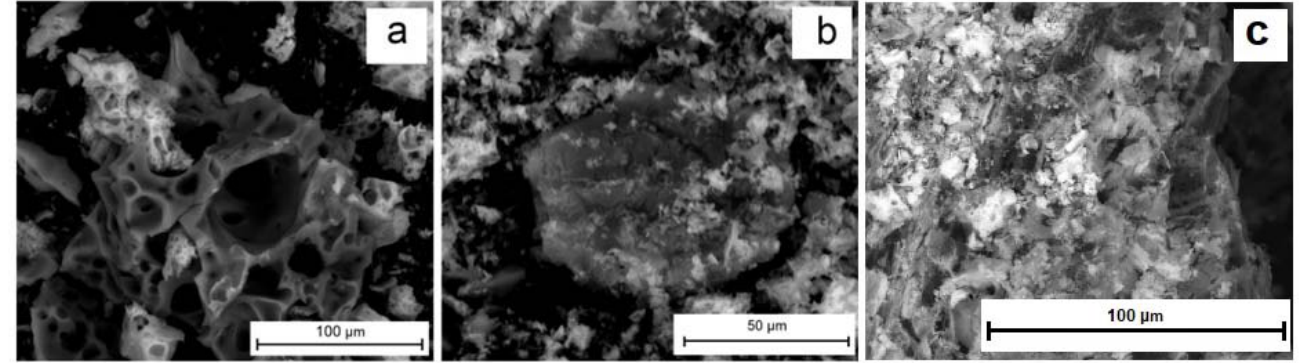
Figure 2. Micrographs of synthesized samples: ( a )—CoFe 2 O 4 , ( b )—CoFe 2 O 4 /C, ( c )—CoFe 2 O 4 /S.